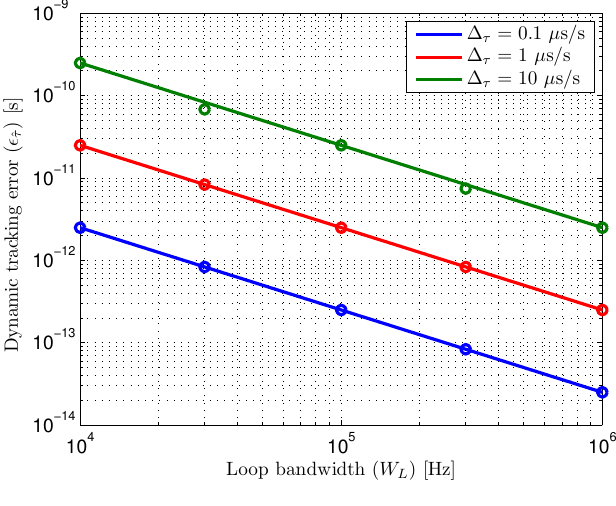
Figure 13. Dynamic error as a function of loop bandwidth ( W change ( ∆ ). Theoretical (solid) and IR link analog emulation (circles). τ